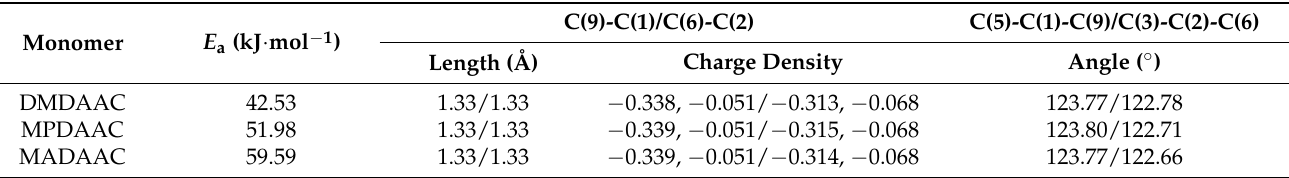
Table 5. The molecular conformation parameters of allyl double bonds and the activation energies of primary radical homopolymerization of DMDAAC, MPDAAC, and